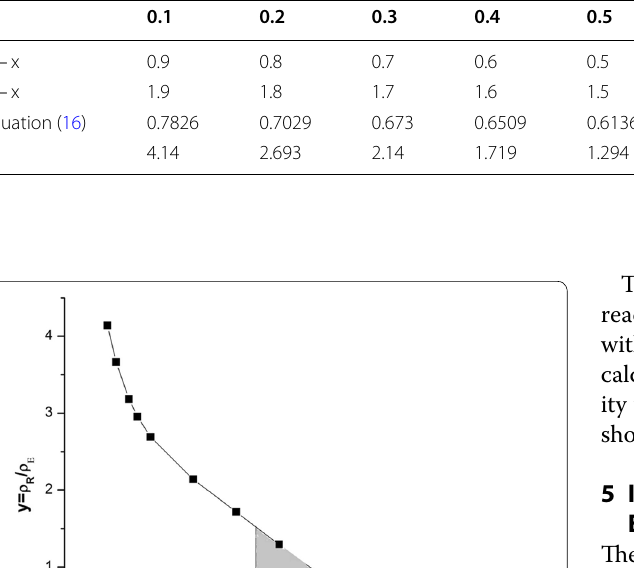
Table 3 x and y values of Eq. (20).